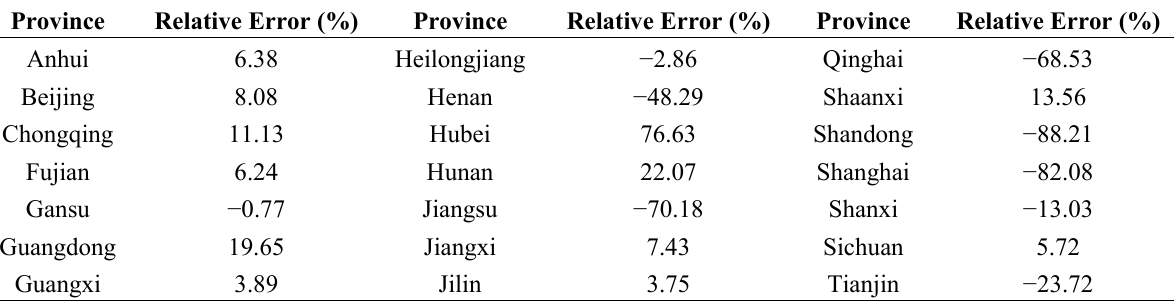
Figure 8. Comparison of biomass derived from field data with AGB prediction from MODIS and GLAS data using biomass of 31 provinces. Table 7. Comparison of estimated total AGB form national map with statistical biomass in 31 provinces. Relative error is the ratio of AGB difference of estimates and forest inventory data to the biomass of forest inventory data. (Due to lack of forest inventory data in Taiwan, Hong Kong and Macau, AGB of these regions were not